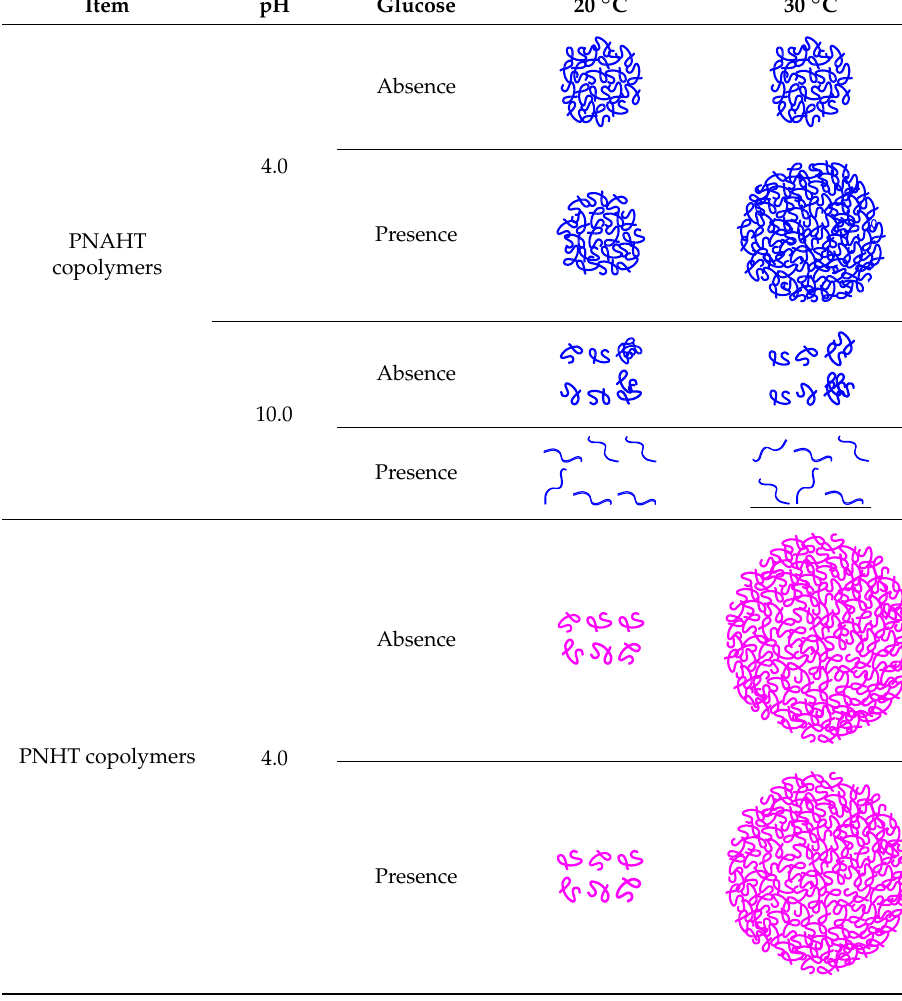
Table 2. Dimension and conformation of PNAHT and PNHT copolymers under different conditions. Item